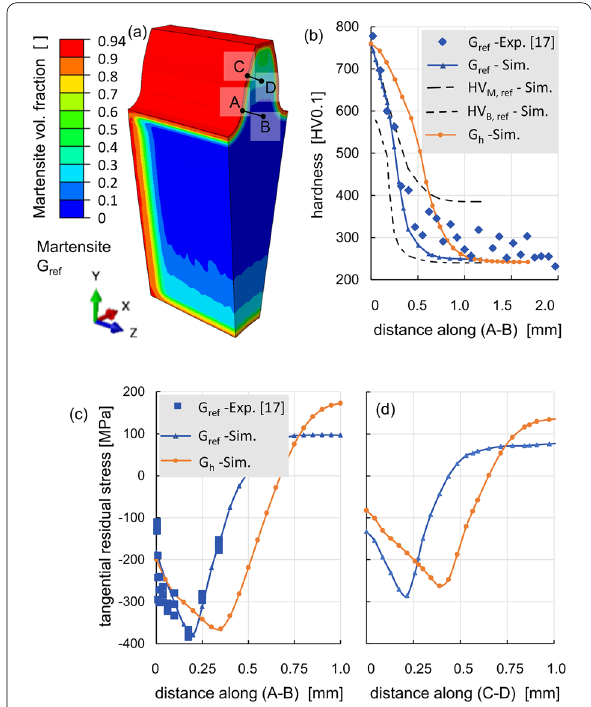
Figure 14 Results of the heat treatment simulation and validation: a martensite volume fraction, b hardness profile in the tooth root, tangential residual stress profiles in the tooth root c and in the tooth flank